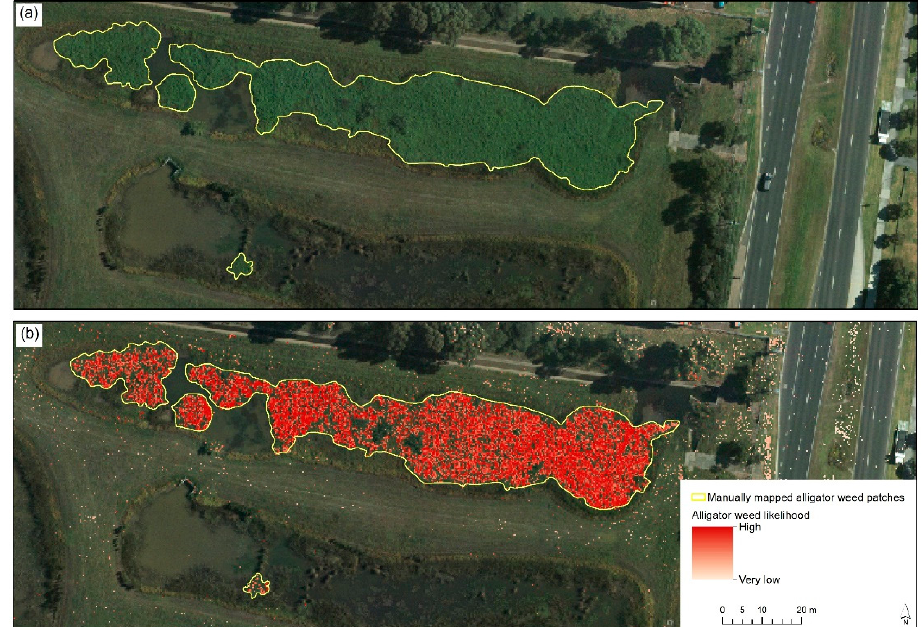
Figure 6. Example output of a waterbody with high levels of alligator weed infestation in 2011 showing ( a ) manually mapped patches of alligator weed and ( b ) the corresponding alligator weed likelihood output.